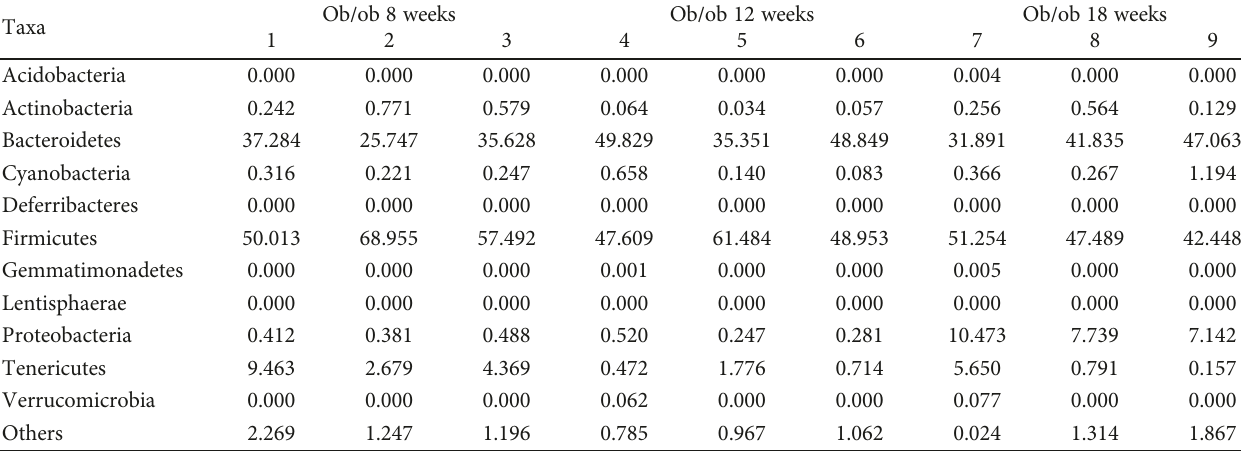
Table 1: Relative abundance in the percentage of the major OTUs at the phyla level in each fecal sample from ob/ob mice. Taxa